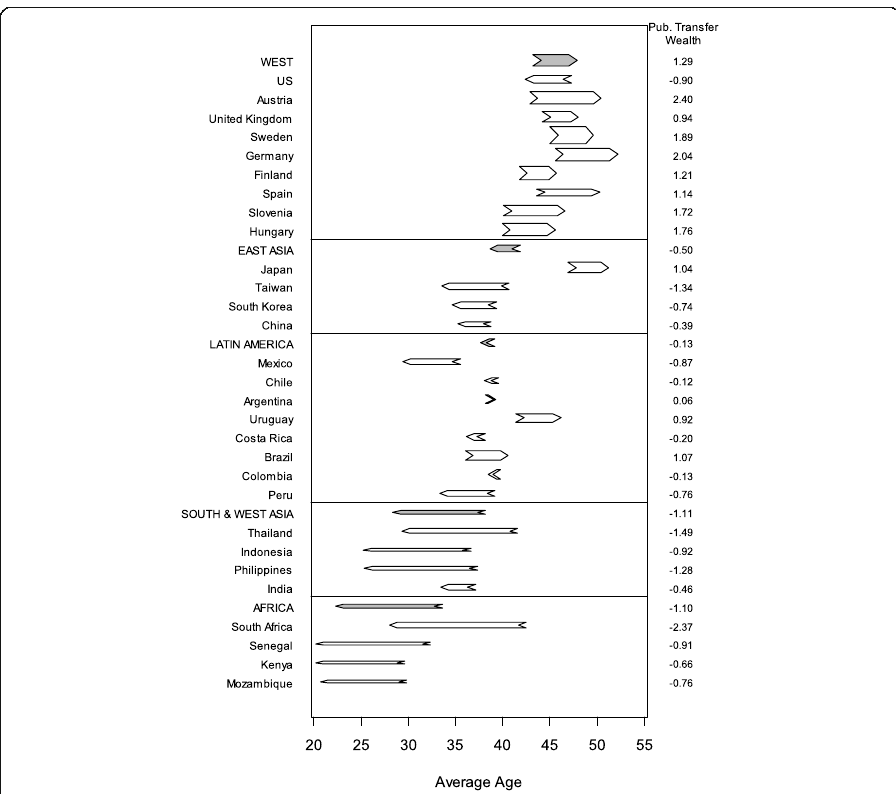
Fig. 6 The direction of flow for public transfers. Note: Head of arrows is average age of receiving benefit, and tail is average age of paying tax. Countries ranked within region by per capita GDP (ppp-adjusted, US$) in 2005. Regional averages are unweighted. Regions ranked by per capita GDP. Source: For National Transfer Accounts data, see ntaccounts.org. Average age and per capita calculations use United Nations Population Division (2013) population data for year of NTA age